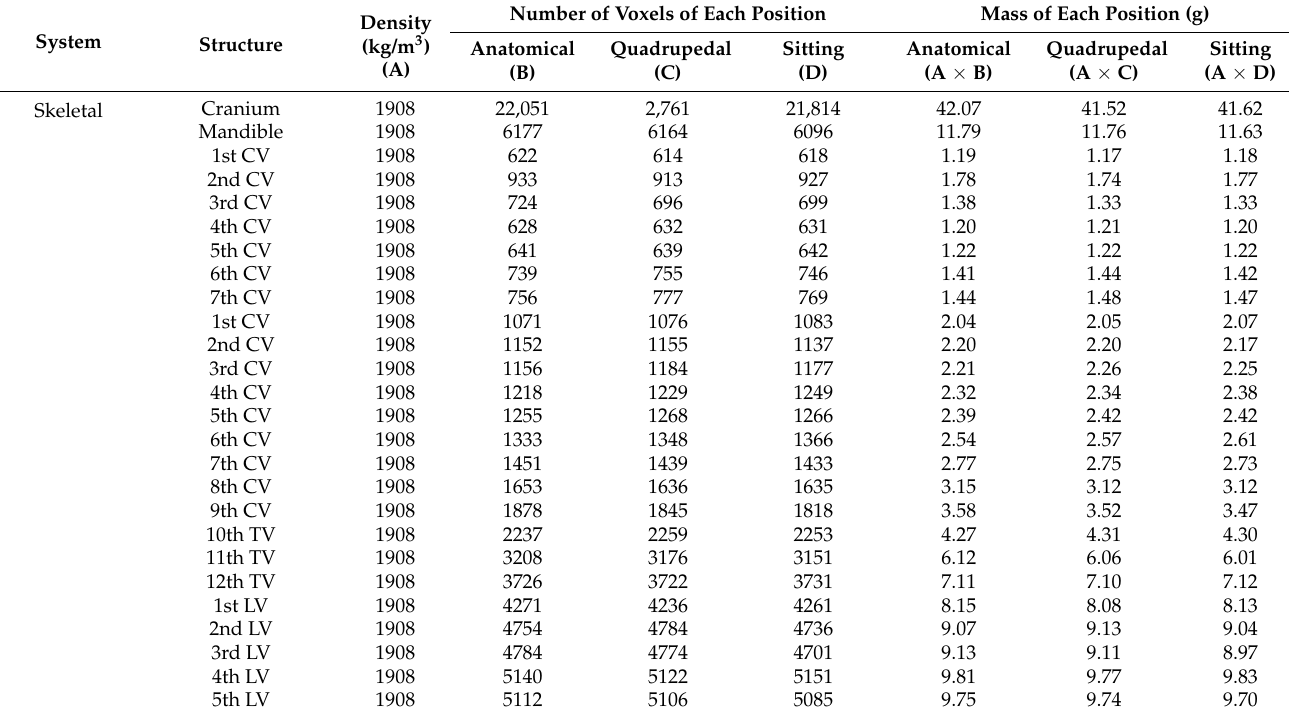
Table A1. Number of voxels of 177 structures in the monkey phantoms of anatomical, quadrupedal, and sitting positions.